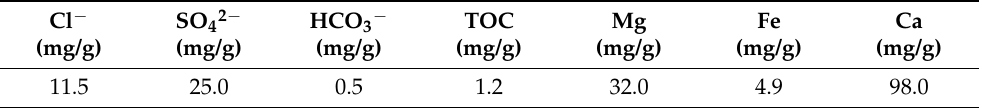
Table 1. Piraeus soil analysis according to